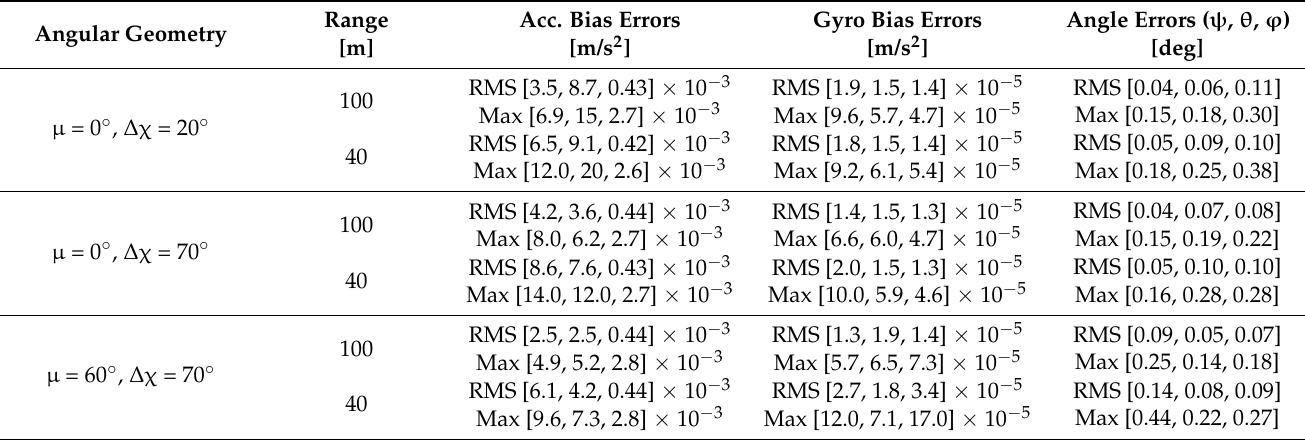
Table 2. RMS and maximum error by varying range of the formation. Only cooperative filter results RMS and maximum error are reported. Angular